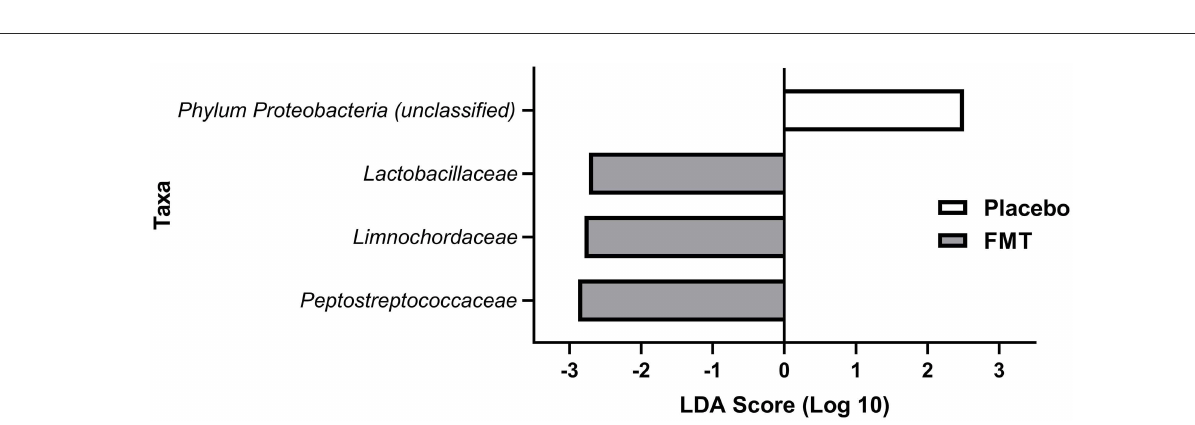
FIGURE5 LEfSE analysis of preferentially abundant bacterial families at 13 weeks (1 week after completing treatment with either FMT or placebo) in treatment groups after eliminating families found in < 30% of subjects in the treatment groups. All differences shown here at 13 weeks were statistically significant (see Results). No families were preferentially abundant in one of the treatment groups but not the other for baseline (pre-treatment) or at 6 weeks